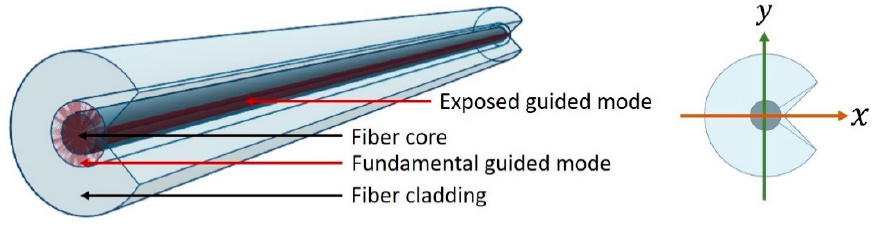
Figure 1. Schematic diagram of a C-shaped birefringent optical fiber.